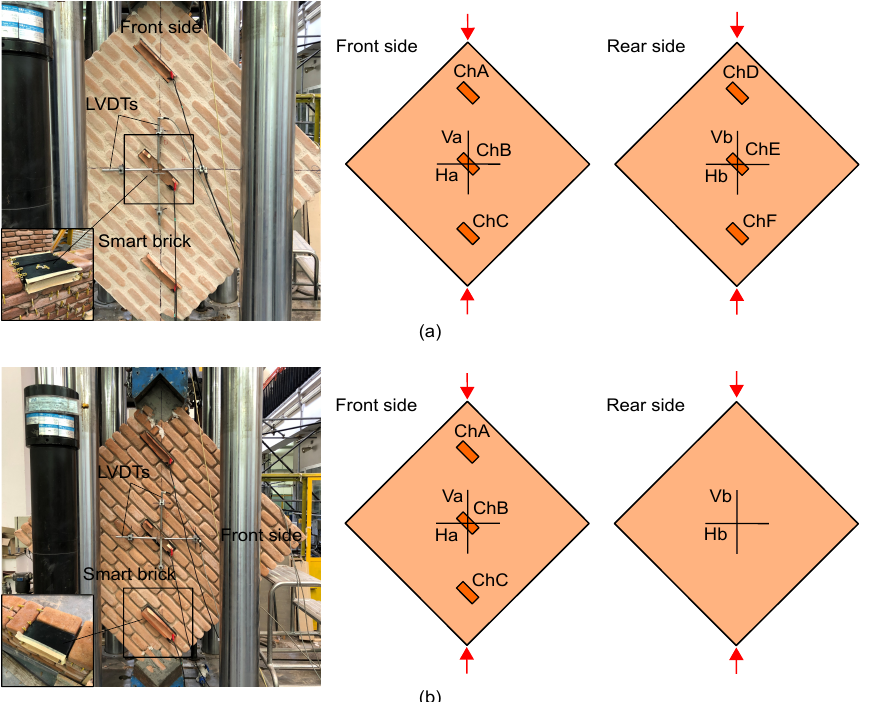
Figure 2. Pictures of the tested masonry wall specimens with the indication of the placement of smart bricks and LVDTs: ( a ) Specimen A with intact mortar layers; ( b ) Specimen B with degraded mortar